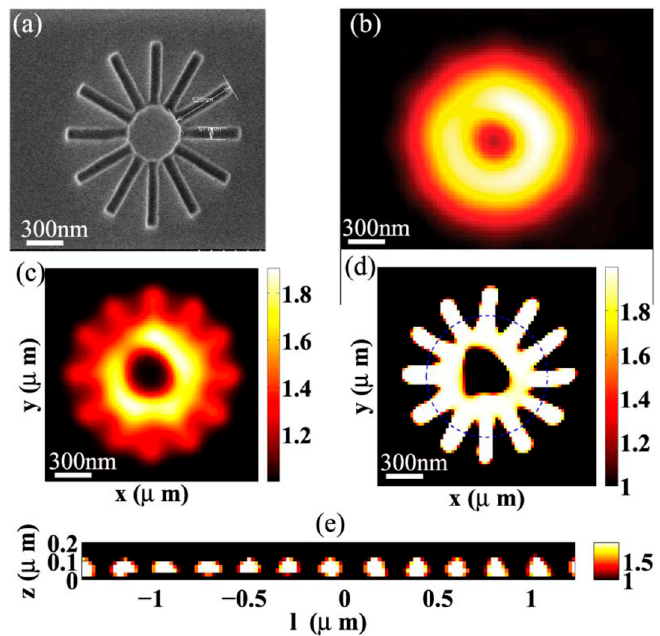
Figure 5. Images of a resin star sample, sample information: 97 nm wide rods of length 520 nm and height 140 nm on a Si substrate. ( a ) Image of the sample obtained by SEM. ( b ) Image of the sample obtained by Darkfield microscopy numerical aperture (NA) of objective 0.95. ( c ) Reconstruction obtained with a hybrid inversion method from tomographic diffraction microscopy data with NA equals to 0.95. ( d ) Permittivity reconstructed with a bounded inversion method using the prior knowledge of the resin permittivity from the same data as ( c ). ( e ) Permittivity distribution along the z direction versus the curvilinear abscissa of the dashed circle in ( d ) [10].